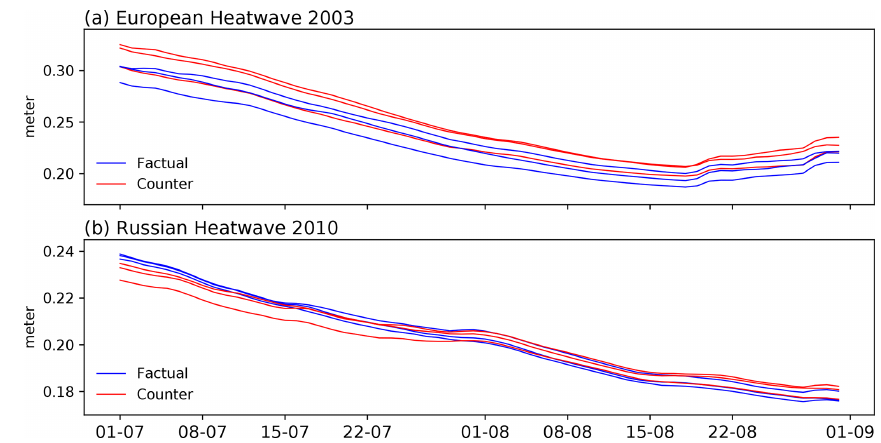
Figure 7. Average soil wetness in the root zone [m] averaged over Europe in 2003 and Russia in 2010 during July and August of each year. The factual simulations are shown in blue and the counterfactual simulations in